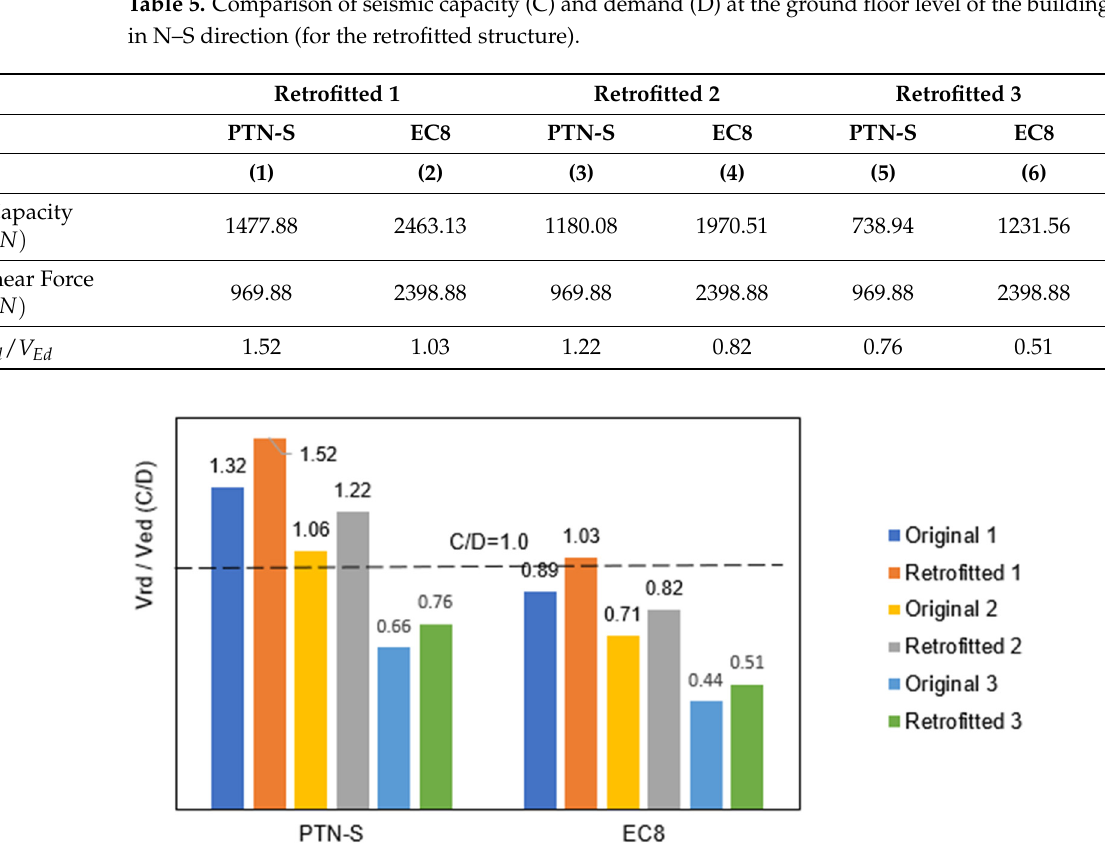
Figure 24. Seismic capacity versus demand (C/D) ratio for the ground floor of the building in N–S direction (for the original and retrofitted building).